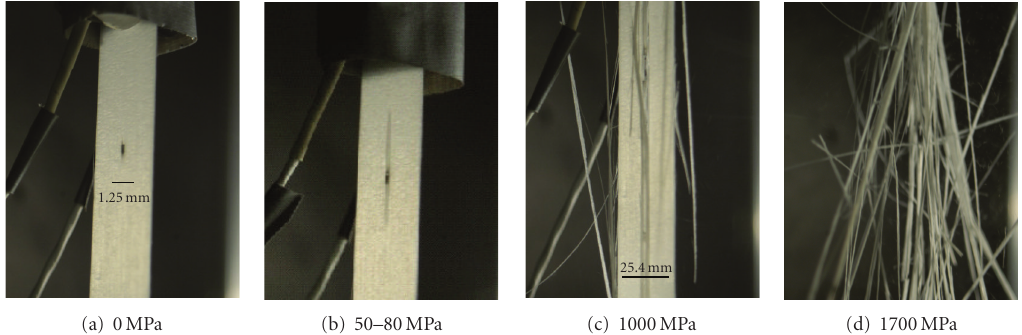
Figure 9: (a) through (c) initiation of failure at the implant in [0] 6 samples with integrated device; catastrophic failure